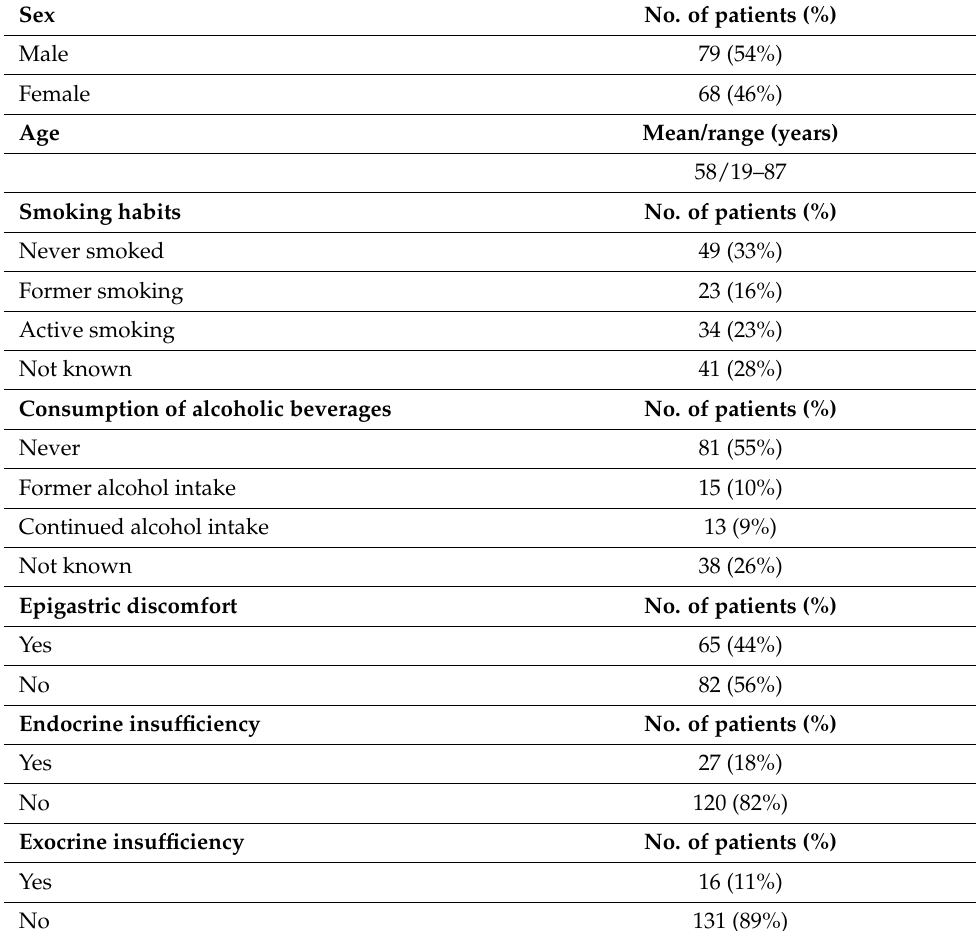
Table 1. Overview of central clinical elements pertinent to chronic pancreatic